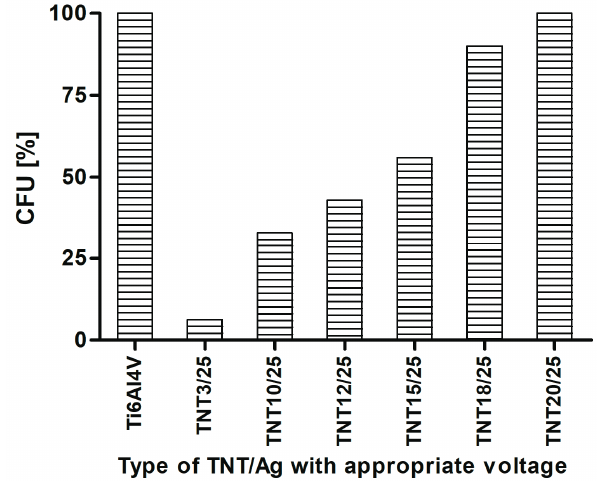
Figure 8. S. aureus ATCC 29213 biofilm formation on the surfaces of Ti6Al4V alloy foil modified by TiO 2 nanotubes (TNT) tested by CFU method. The results are presented as mean percentage ± standard deviation (S.D.) of S. aureus CFU reclaimed after 24 h from Ti6Al4V alloy biomaterials modified by TiO 2 nanotubes with dispersed Ag nanoparticles (TNT/Ag), in comparison to bacterial CFU recovered from control (unmodified) biomaterial (Ti6Al4V) considered as 100%.